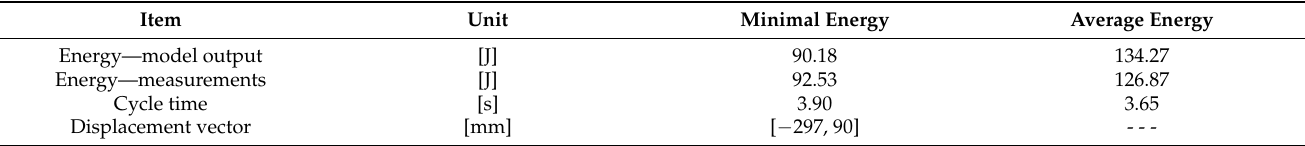
Table 9. Results of minimisation of specific energy